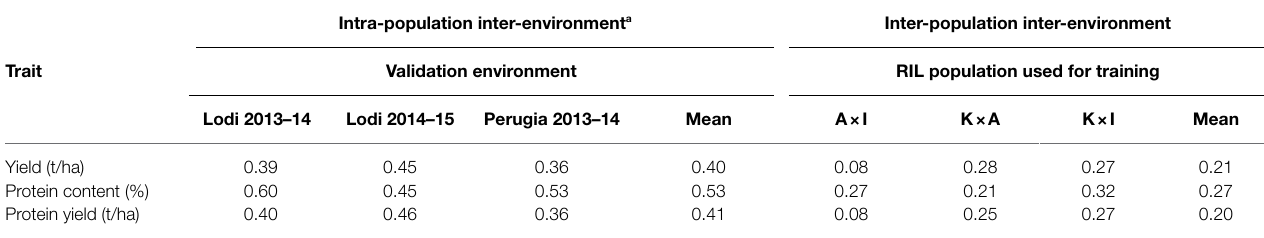
TABLE 7 | Intra-population and inter-population inter-environment predictive ability for three pea traits obtained by Ridge regression BLUP modelling using two environments for model training and one for validation and, for inter-population predictions, one RIL population for model training aimed to predictions for the other populations.